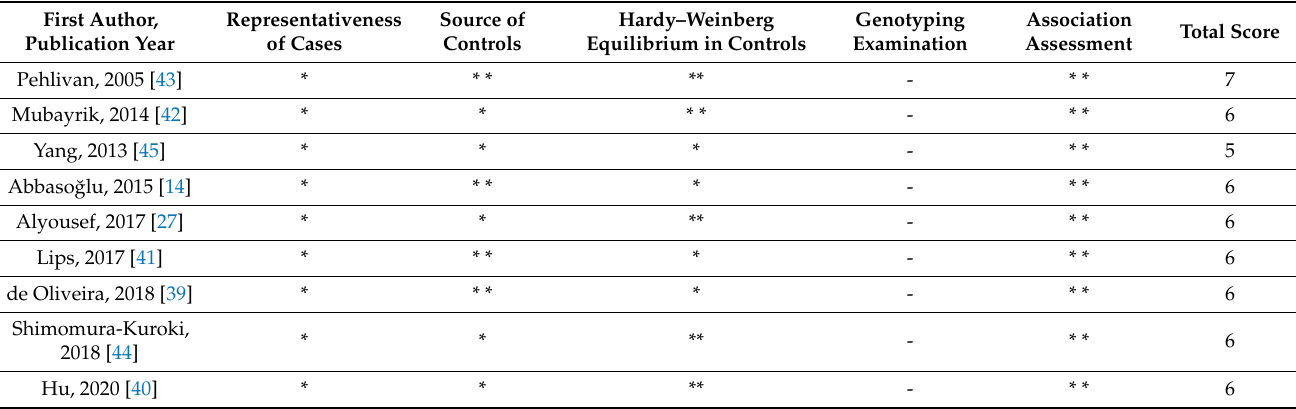
Table 2. Quality evaluation of the articles by modified Newcastle–Ottawa